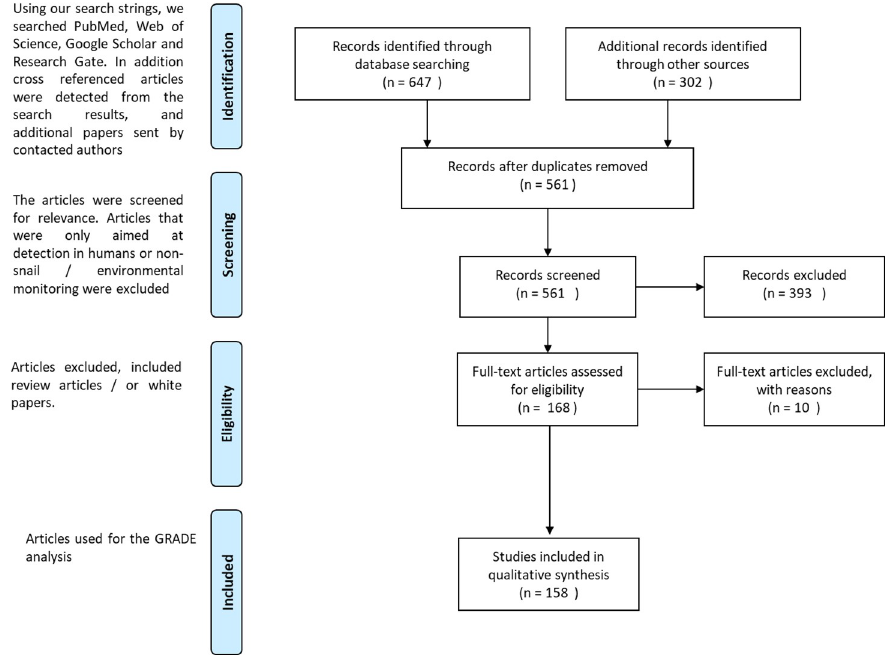
Fig 2. Overview of the PRISMA